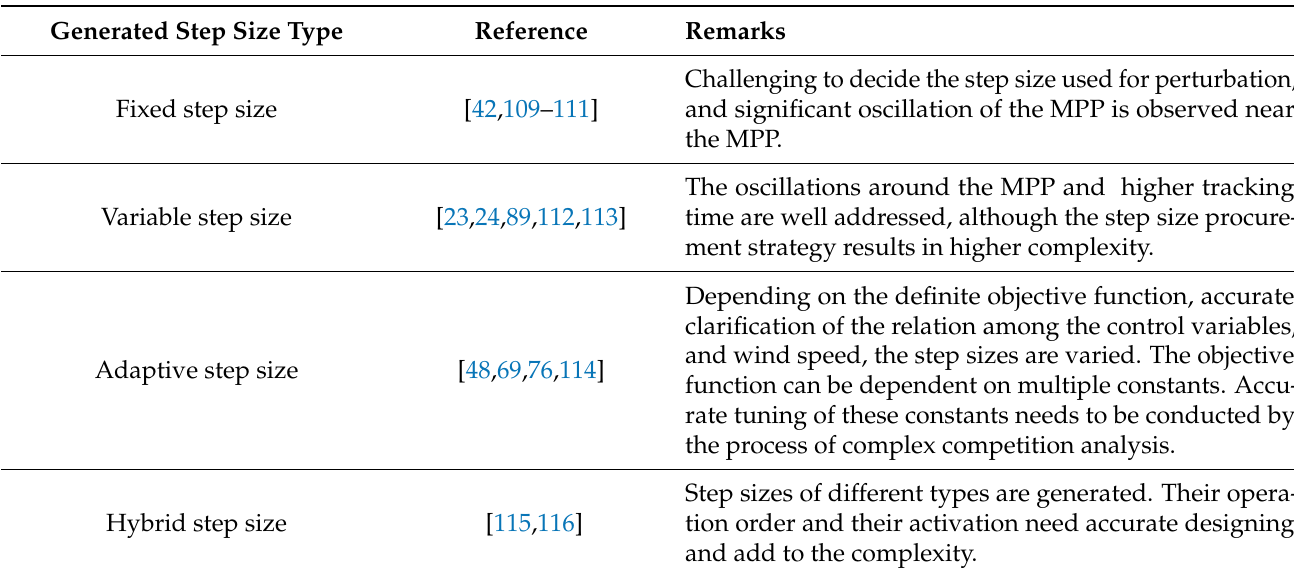
Figure 17. Classification of P&O algorithm. Reused with permission from Ref. [3]. Copyright 2021 Elsevier. Table 5. Comparison of P&O algorithm based types of step sizes